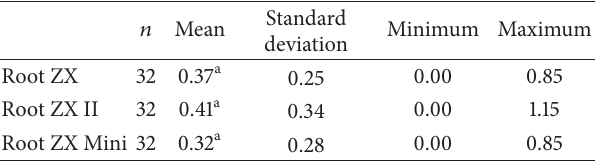
Table 1: Mean, standard deviation, and error range of the experi- mental groups. 𝑛 Mean